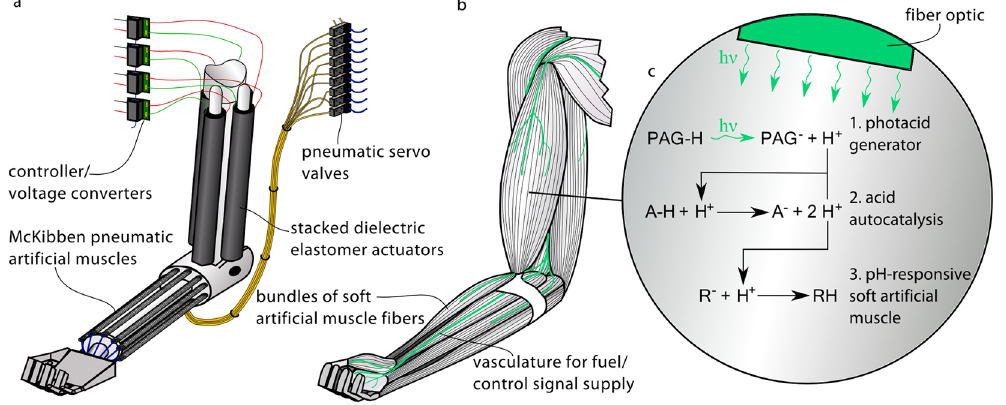
Figure 1. Comparison between current artificial-muscle-based robotic systems and the proposed bioinspired systems enabled by molecular-level control signal amplification. ( a ) Conventional robotic system. While the use of multiple soft artificial muscles for robotic actuation can lead to both a large range of motion and high performance (specific power, safety, selective recruitment, redundancy, morphological computation etc.), such an arrangement requires the use of many hard and bulky external switches or valves, incompatible with both the properties of the soft artificial muscles and those of future bioinspired robotic systems. ( b ) Proposed molecular- level-controlled robotic system. The deficiency of current systems is addressed in this study through the development of a molecular-level approach to control signal amplification. ( c ) Detail of investigated system: (1) light generates an acid, (2) which triggers an acid autocatalytic reaction, (3) resulting in the contraction of a pH- responsive soft artificial muscle. Such an approach enables the development of biomimetic robots containing thousands of individually addressable soft artificial muscles, controlled with the smallest of inputs transmitted through embedded fibre optics and the individual artificial muscle